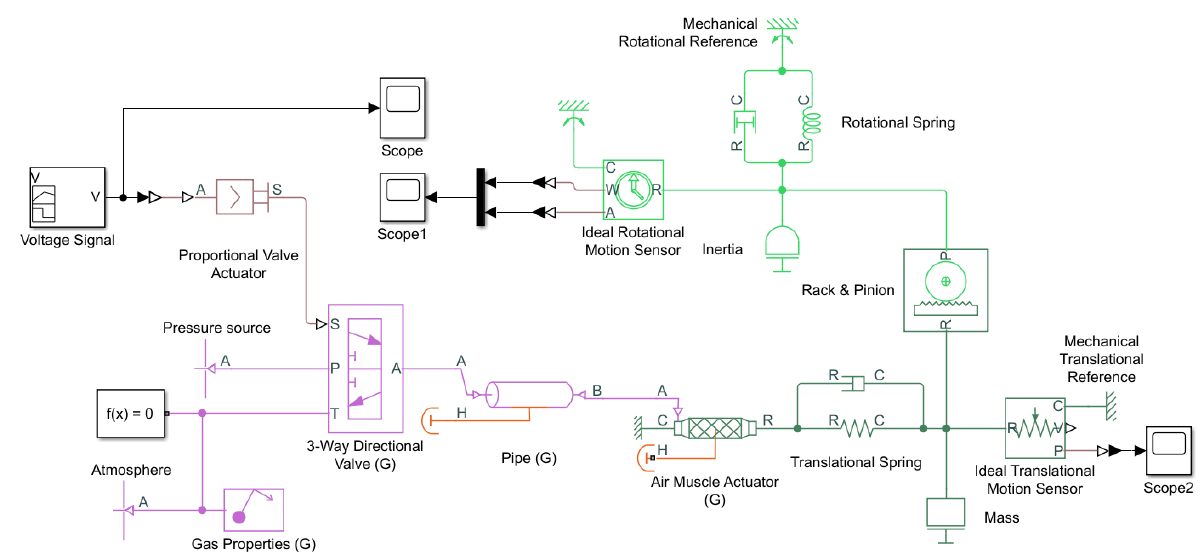
Figure 6. Functional model of the rehabilitation equipment actuation system.